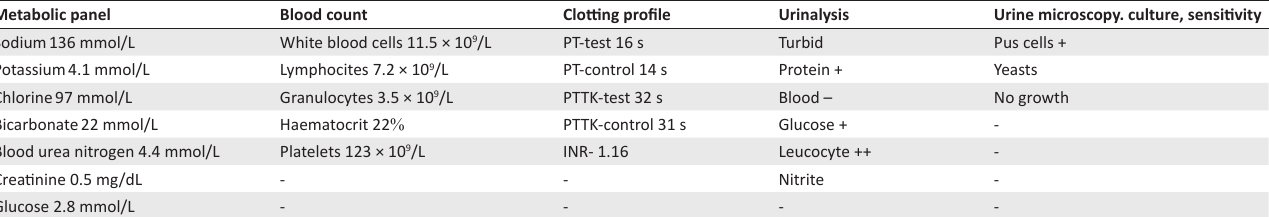
FIGURE 1: Sonogram of the left kidney of an emphysematous pyelonephritis patient at the Usmanu Danfodiyo University Teaching Hospital, Sokoto, Nigeria, November 2019. Figure shows renomegaly, reduced renal parenchyma echogenicity and multiple irregular mixed echoes with dirty shadowing (blue TABLE 1: Laboratory data of the emphysematous pyelonephritis patient on the second day of admission at the Usmanu Danfodiyo University Teaching Hospital, Sokoto, Nigeria, November 2019. Metabolic panel Blood count Clotting profile Urinalysis Urine microscopy. culture, sensitivity